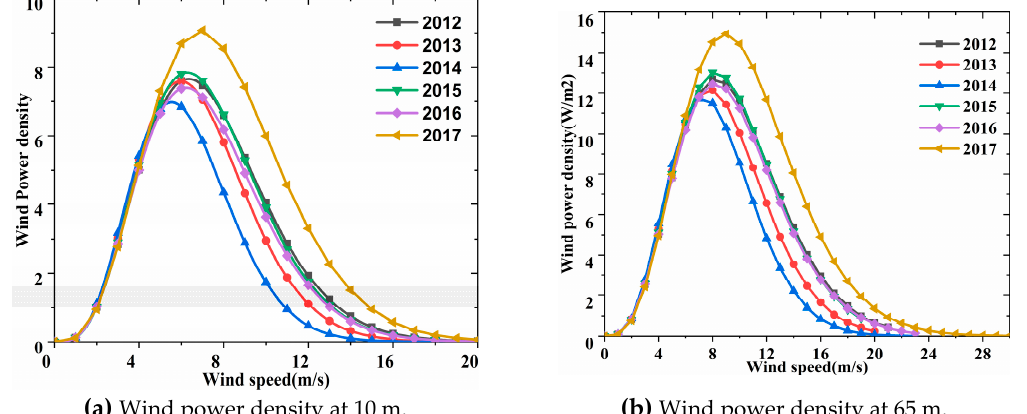
Figure 8. Wind power density at ( a ) 10 m and ( b ) 65 m from 2012 to 2017.